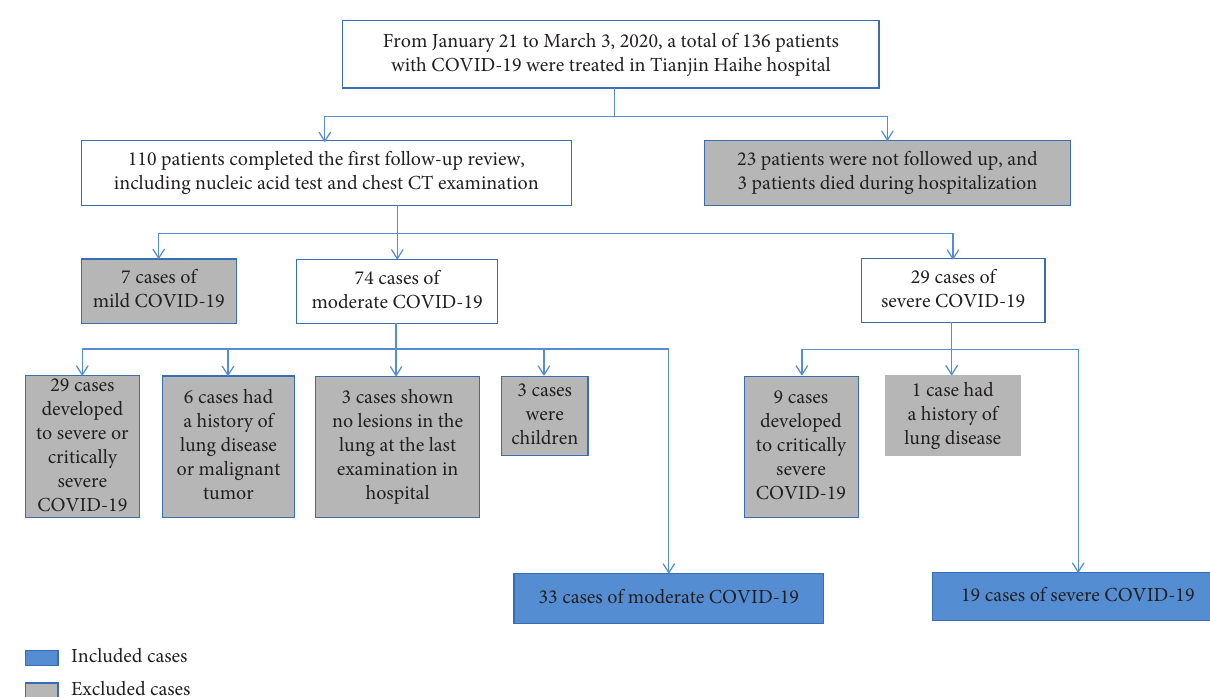
Figure 1: Flow chart of inclusion and exclusion for COVID-19 patients in this